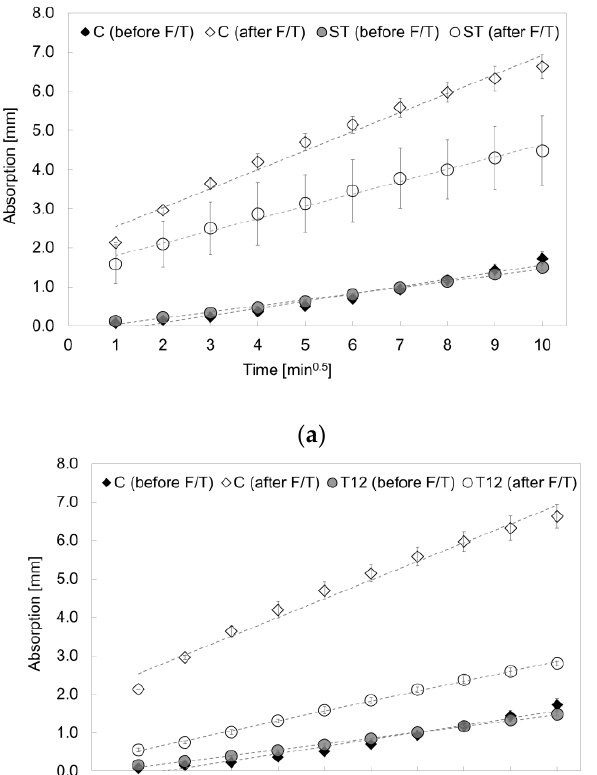
Figure 8. Water absorption rate curves for series ( a ) ST, ( b ) T8, ( c ) T12 and ( d ) T30 before and after freeze/thaw cycles compared to series C. The error bars represent the standard deviation. The dotted lines represent the linear interpolation used to calculate the sorptivity values. Figure 9. Microscopy images of samples ST and T8 and details of the shreds and fibres, respectively.